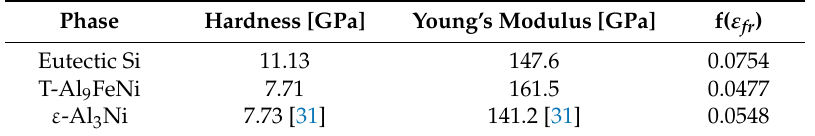
Table 4. Hardness, Young’s modulus, and relative fracture strain for eutectic Si and Ni-based phases